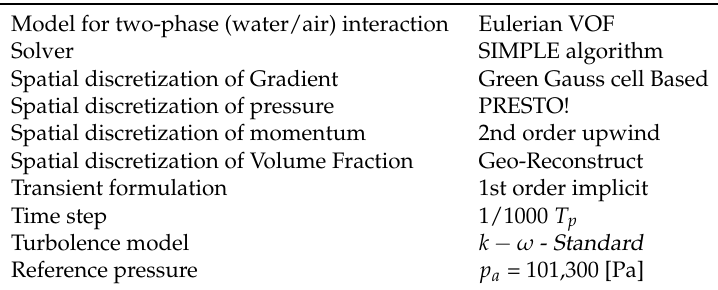
Table 1. CFD simulation set up